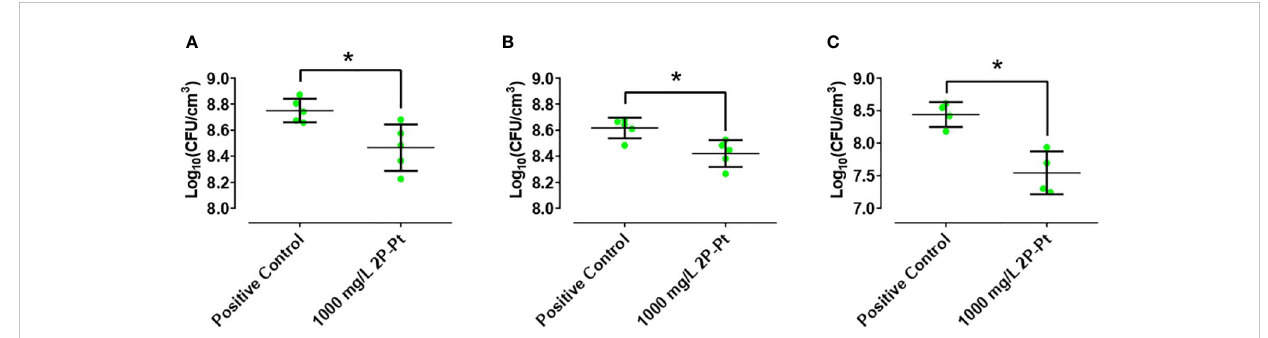
FIGURE 4 Effect of 2P-Pt on the development of bio fi lm in a wound-like medium at a concentration of 1,000 mg/L in ATCC 25923 (A) , MRSA 1 (B) and MRSA 2 (C) . *p-value< 0.05 in Wilcoxon test. The bars represent the interquartile